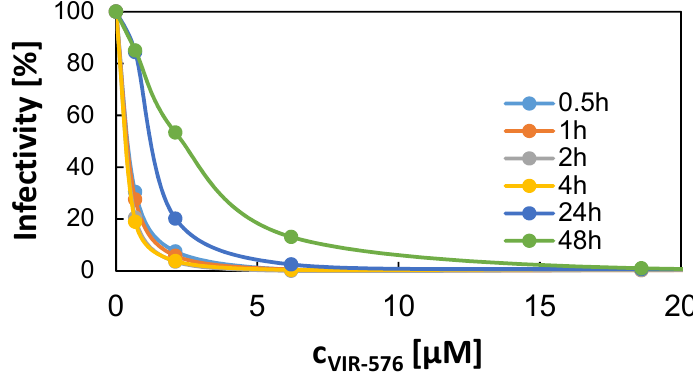
Figure 5. Concentration-dependent VIR-576-induced inhibition of HIV-1 infection in TZM-bl cells in vitro as a function of pre-incubation time in 10% fetal calf serum (FCS) before addition of the HIV-1 virus. Error smaller than the size of the data points.